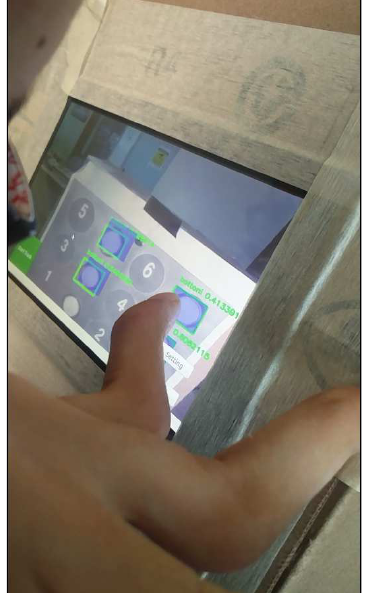
Figure 7. Touching interface tested by a